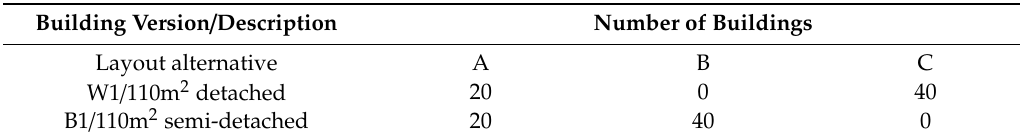
Table 2. List of buildings of each type for layout alternatives A, B and C.